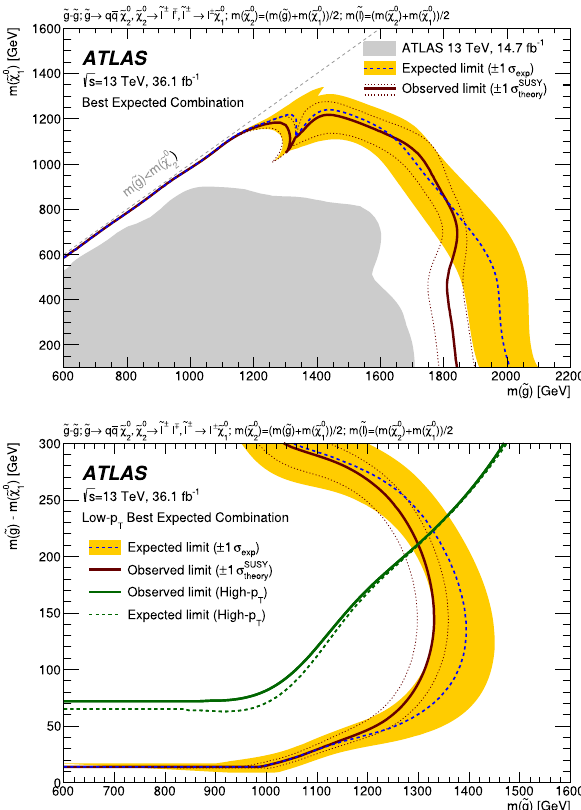
Fig. 12 Expected and observed exclusion contours derived from the combination of the results in the high- p T and low- p T edge SRs based onthebest-expectedsensitivity(top)andzoomed-inviewofthelow- p T only (bottom) for the slepton signal model. The dashed line indicates the expected limits at 95% CL and the surrounding band shows the 1 σ variation of the expected limit as a consequence of the uncertainties in the background prediction and the experimental uncertainties in the sig- nal ( ± 1 σ exp ). The dotted lines surrounding the observed limit contours indicate the variation resulting from changing the signal cross-section within its uncertainty ( ± 1 σ SUSY ). The shaded area on the upper plot theory indicates the observed limit on this model from Ref. [15]. In the lower plot the observed and expected contours derived from the high- p T SRs alone are overlaid, illustrating the added sensitivity from the low- p T SRs. Small differences between the contours in the compressed region are due to differences in interpolation between the top and bottom plot